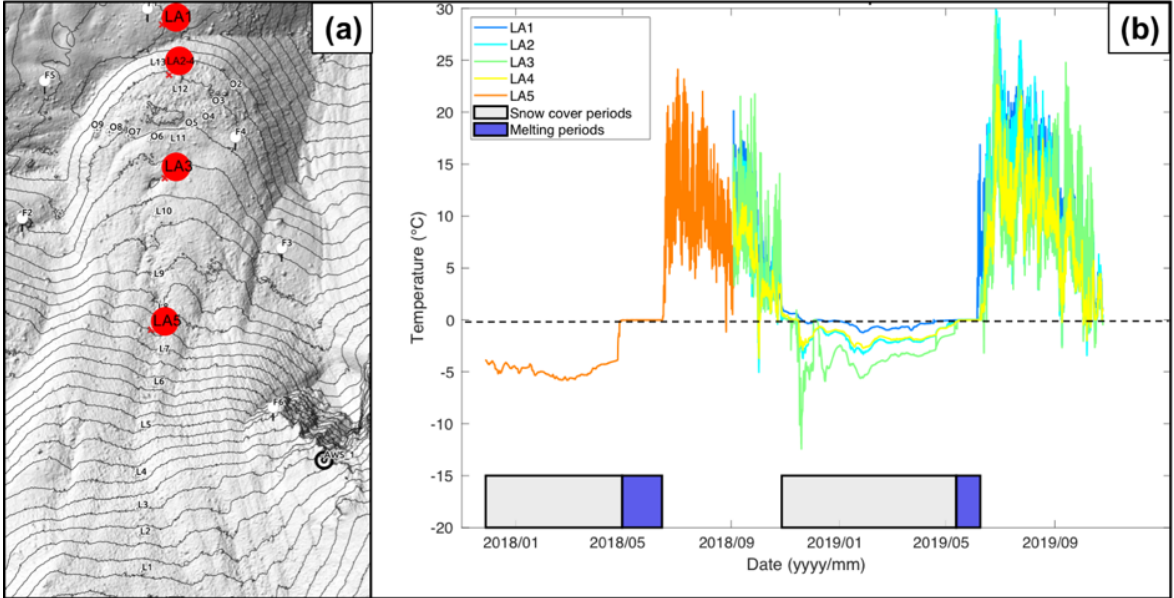
Figure A1. (a) Location of the five miniature temperature data loggers (MTDs) that record the temperature of the subsurface (below 2–10cm of debris) every hour, shown in (b) over the first 2 years of data, with snow cover (grey boxes, when temperature is below 0 ◦ C) and melting (blue boxes, when zero-curtain effect occurs) periods